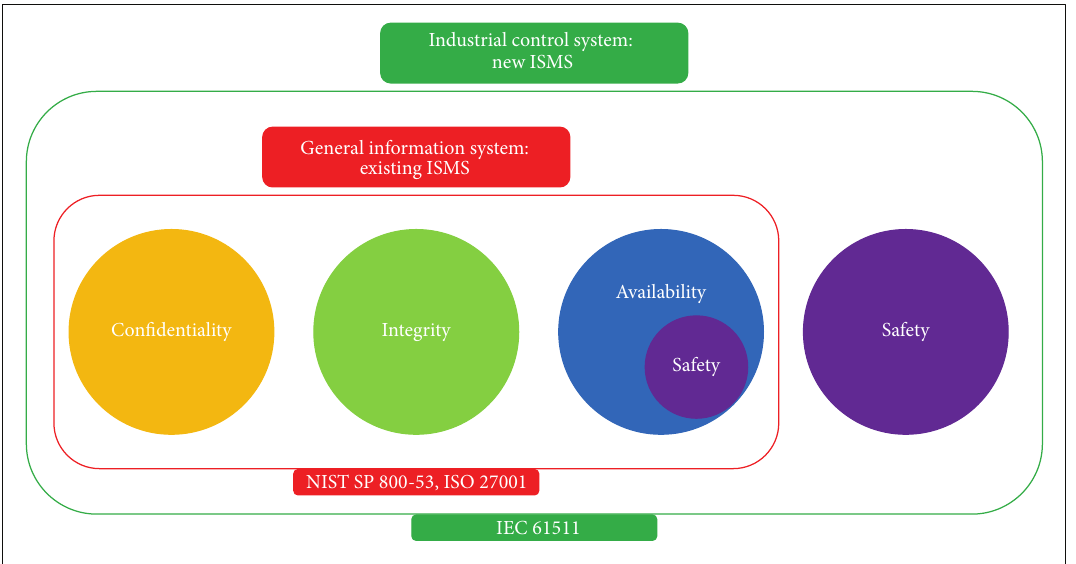
Figure 2: The goal of new information security management system for industrial control